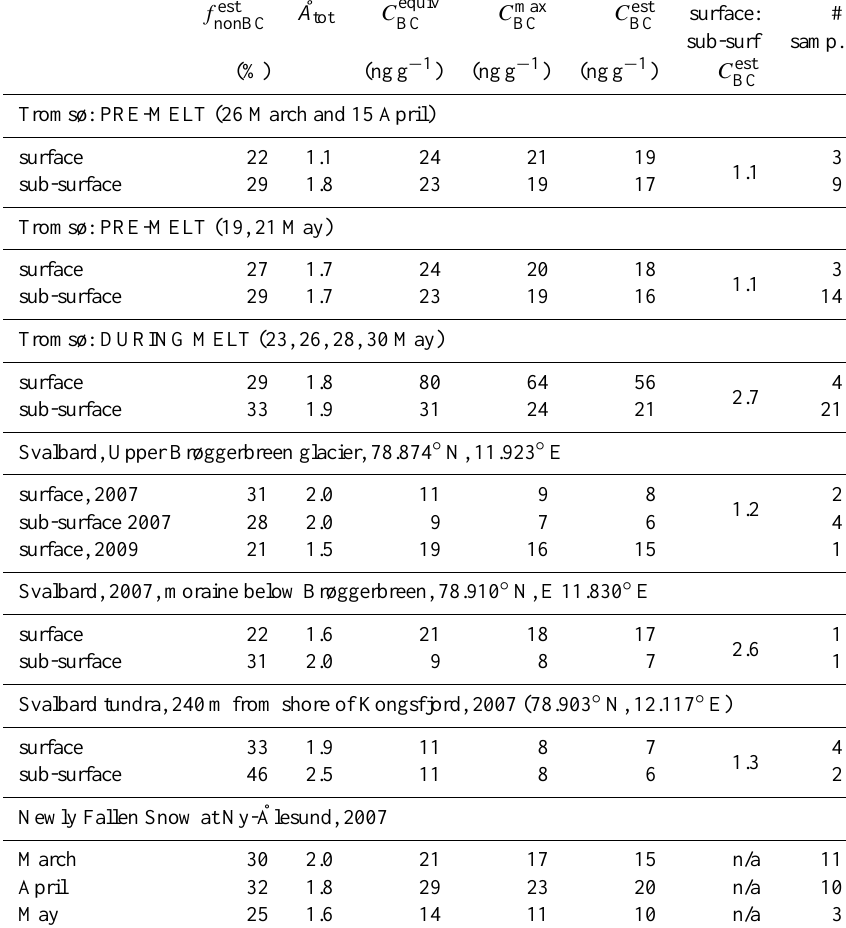
Table 8. Median values from the Fjellheisen plateau above Tromsø, Norway (69.4 ◦ N, 18.6 ◦ E, 421m) in the spring of 2008, and from Svalbard in 2007 and 2009. All Svalbard samples are from near the town of Ny- ˚Alesund (78.917 ◦ N, 11.933 ◦ E). In locations where two adjacent samples were taken, the average of the pair is considered a single sample. In Tromsø, the total snow depth was 27cm immediately before melt